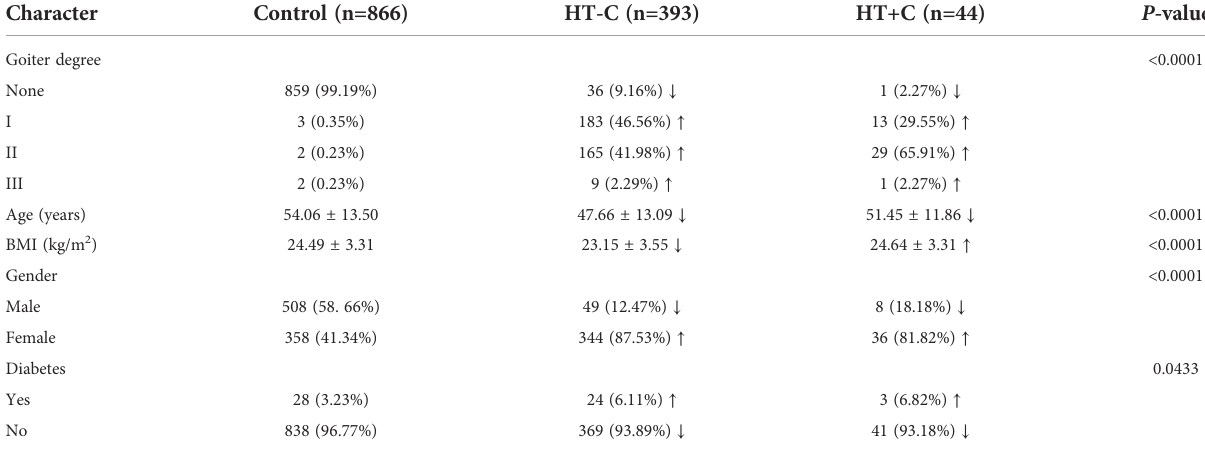
TABLE 1 Clinical characteristics of controls and HT